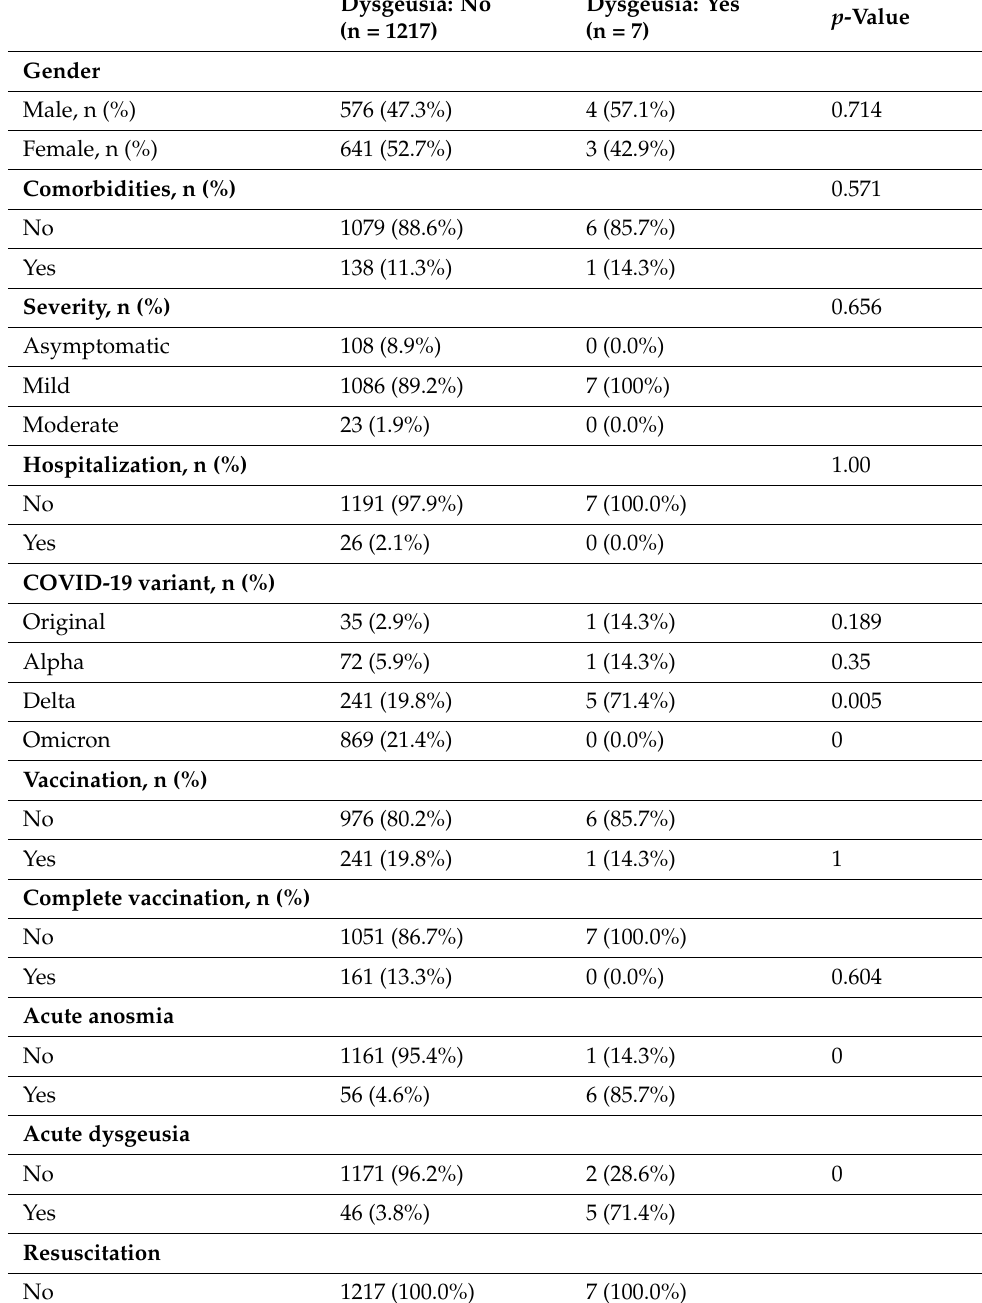
Table 6. Dysgeusia at FUP